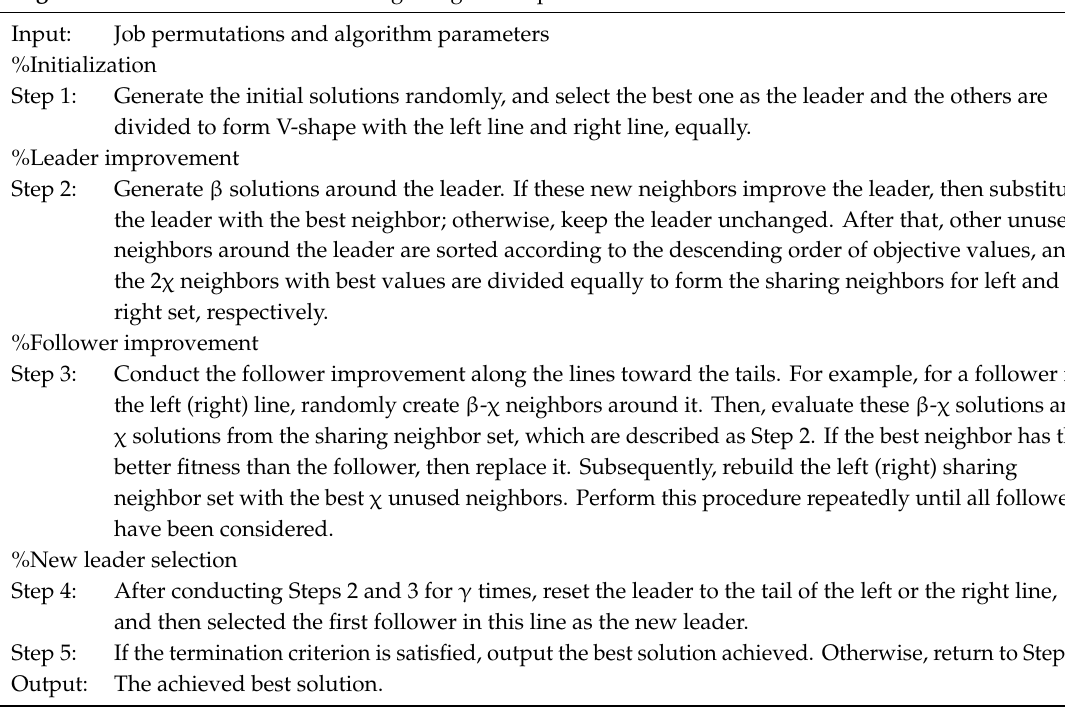
Algorithm 1 Procedure of the basic migrating birds